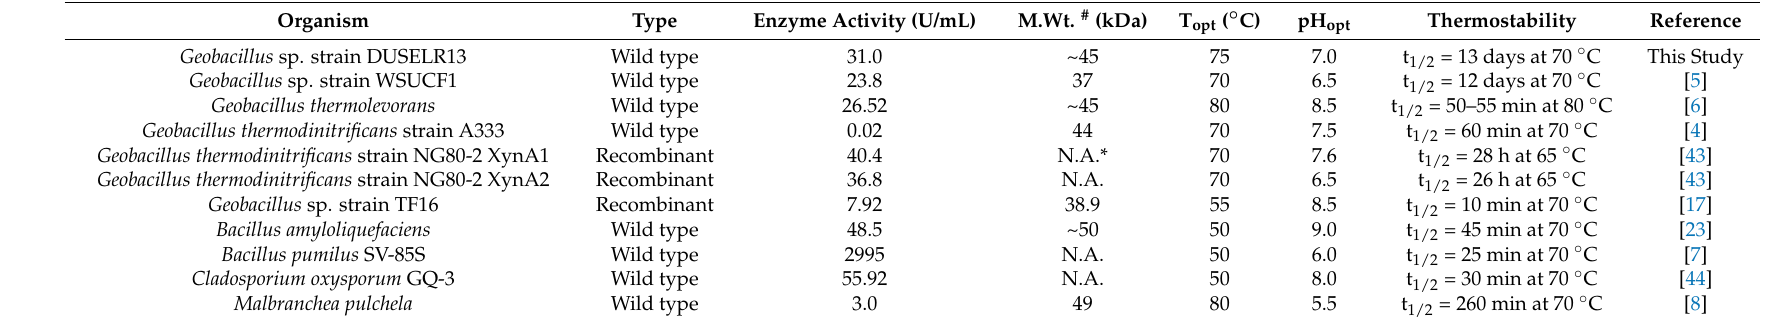
Table 4. The characteristics of various thermostable